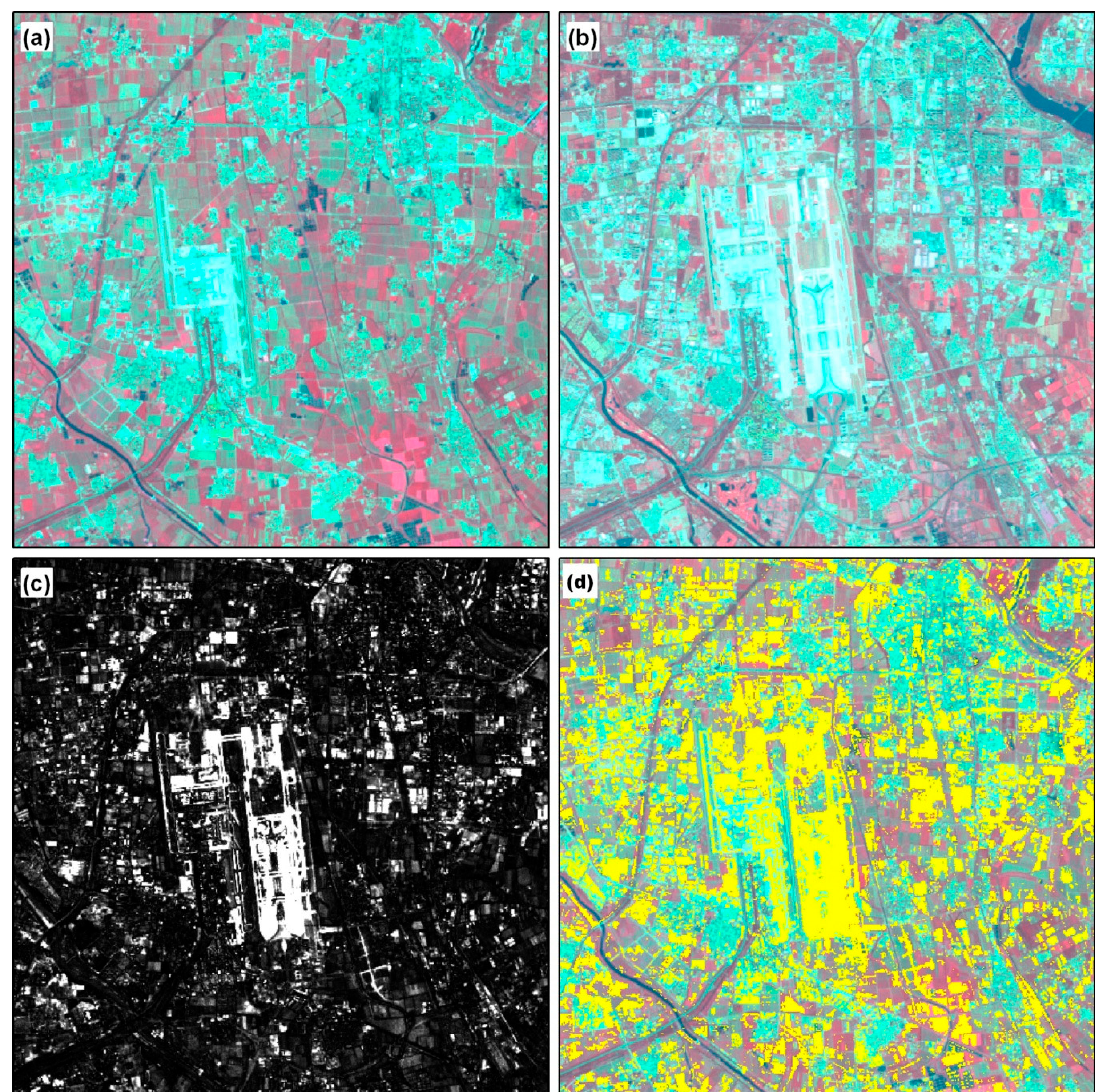
Figure 6. Changed area that was determined by comparing two images: ( a ) ETM+ sub-image at Path 123/Row 032 that was acquired on 2 August 1999; ( b ) Landsat 5 TM sub-image that was acquired on 22 September 2009; ( c ) chi-square image from the IR-MAD algorithm; and ( d ) mask of the changed area, which is shown in yellow against the background image (i.e., Figure 6a).